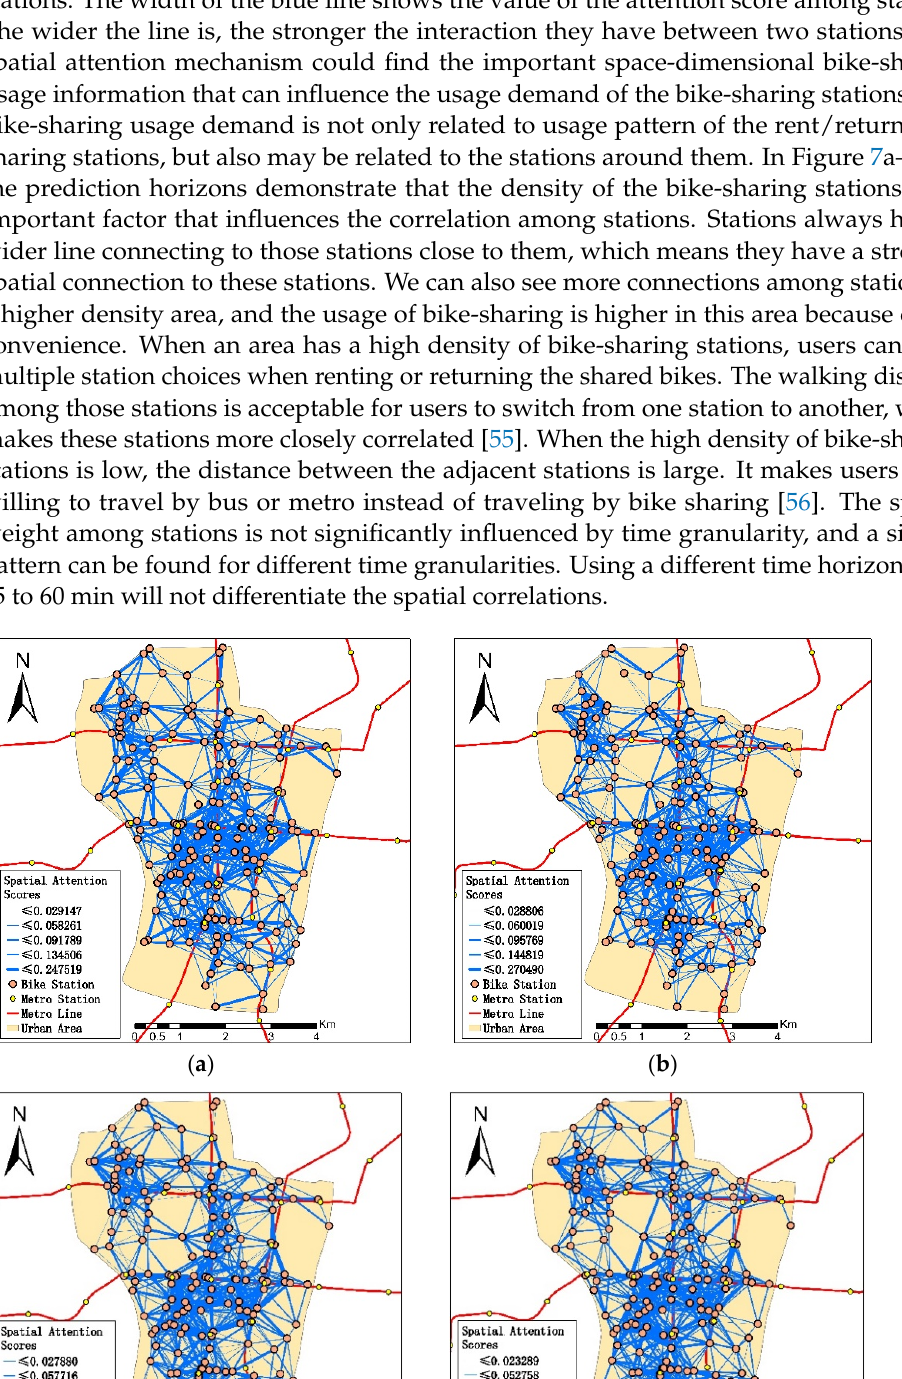
Figure 6. Temporal attention score for each time step of the different prediction horizons. ( a ) 15-min horizon; ( b ) 30-min horizon; ( c ) 45-min horizon; ( d ) 60-min horizon.